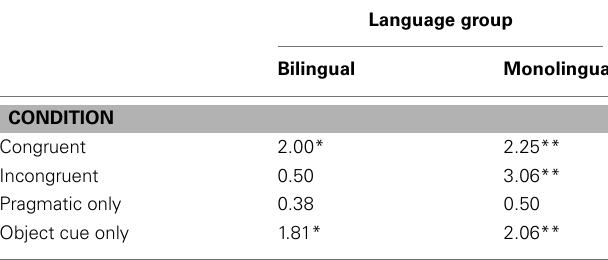
Table 1 | Results for conditions compared to chance for Experiment